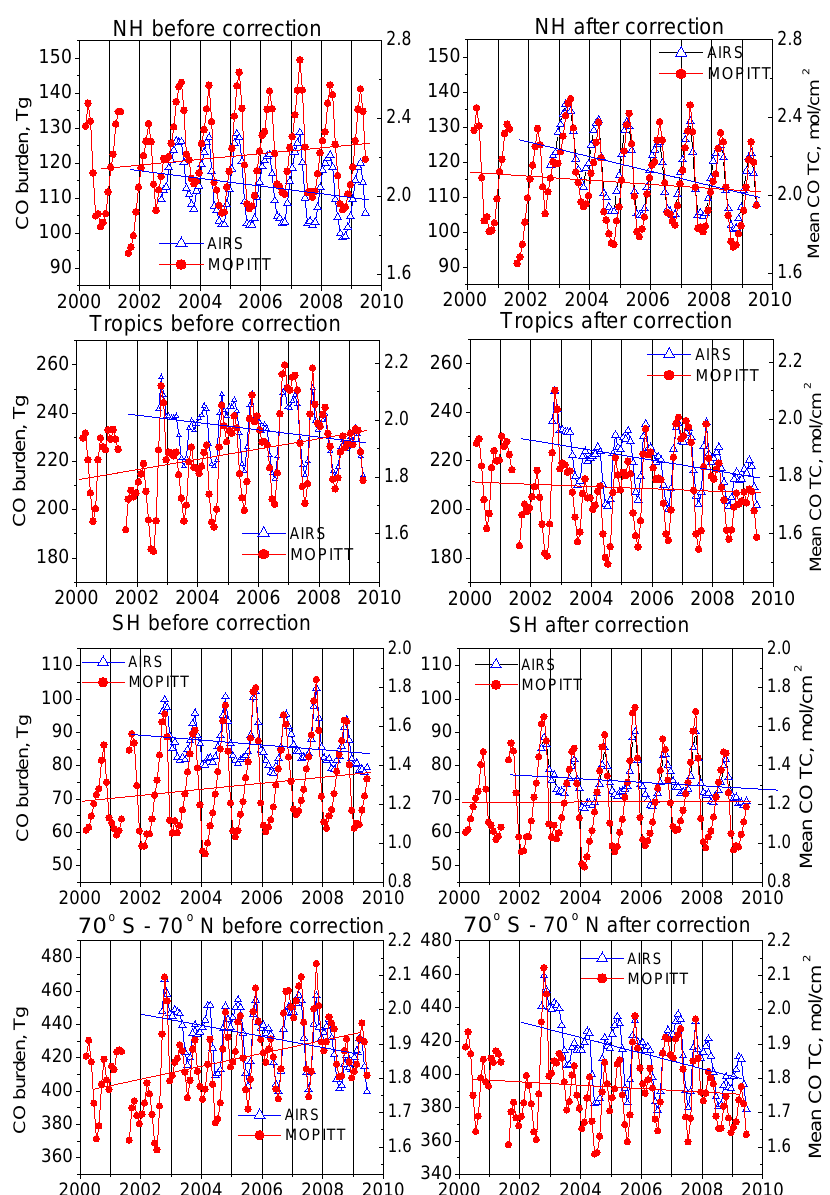
Fig. 7. Effect of correction for four latitudinal belts. Monthly mean CO burdens in Tg for latitudinal belts: 30 ◦ N–70 ◦ N (NH), 30 ◦ S– 30 ◦ N (Tropics), 30 ◦ S–70 ◦ S (SH) before (left) and after (right) correction obtained from comparison with ground-based instruments. The right-side scale corresponds to mean TC in 10 18 moleculescm − 2 . Red and blue straight lines are linear regressions for MOPITT and AIRS, respectively (see also Table